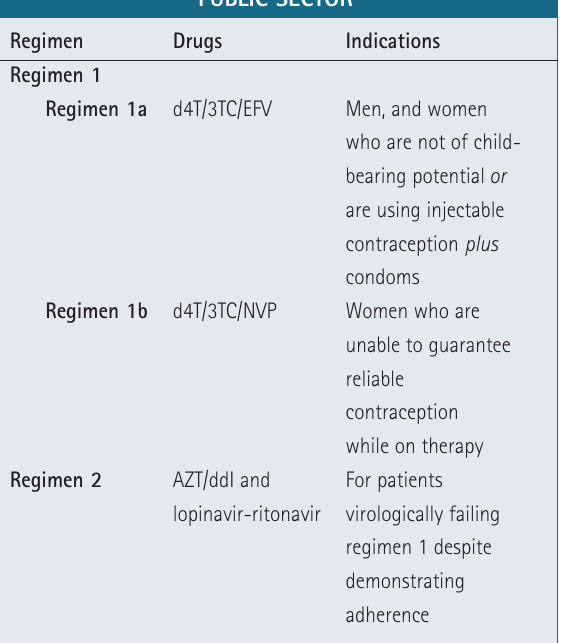
TABLE XII. ART REGIMENS IN THE SOUTH AFRICAN